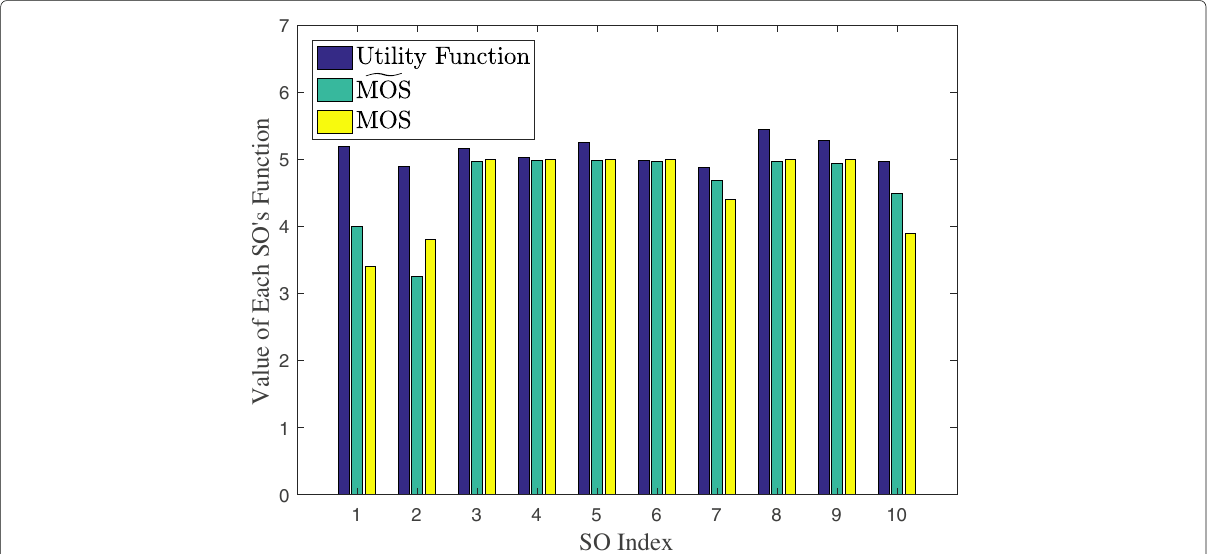
Fig. 5 The comparisons of utility, (cid:28) MOS and MOS for each SO obtained by preforming Algorithm 1